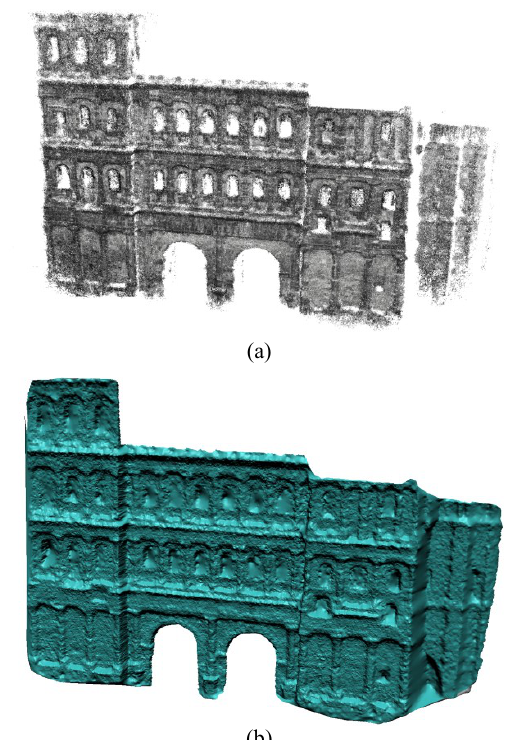
Figure 3. (a) 3D reconstruction results of Porta Nigra taken from the web image repositories; (b) 3D reconstruction results of Porta Nigra using semi- automatic